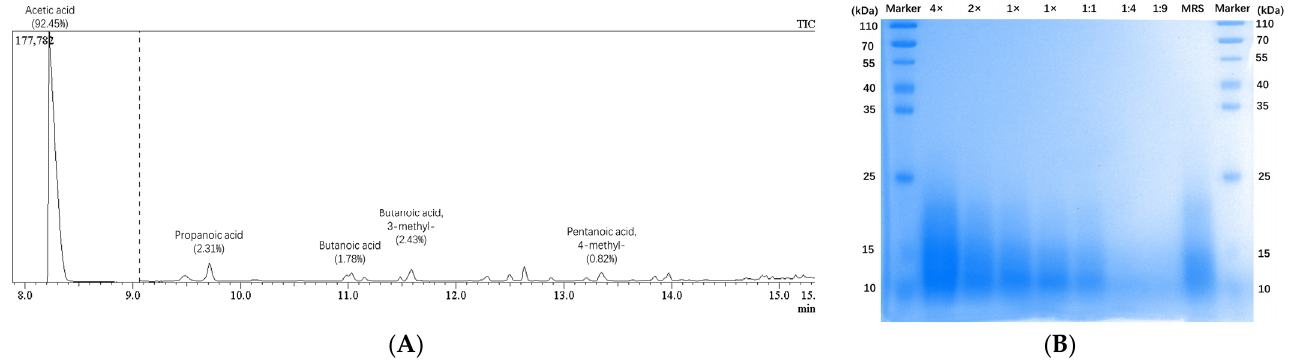
Figure 1. Detection of SCFAs and proteins in LP-csL: ( A ) Chromatographic result of the SCFAs in LP-cs; The main SCFAs were acetic acid; propanoic acid; butanoic acid; and butanoic acid, 3-methyl-, accounting for 92.45%, 2.31%, 1.78%, and 2.43%, respectively; the data in details were listed in Table 1; ( B ) protein bands of LP-cs in SDS-PAGE gel stained using Coomassie brilliant blue. (4× and 2×) concentrated LP-cs with 4- and 2-fold concentration; (1×) LP-cs without concentration and dilution; (1:1, 1:4, and 1:9) the diluted LP-cs with 1:1, 1:4, and 1:9 dilution rate; (MRS) MRS liquid culture medium. Table 1. SCFAs of LP-cs by GC ‒ MS.